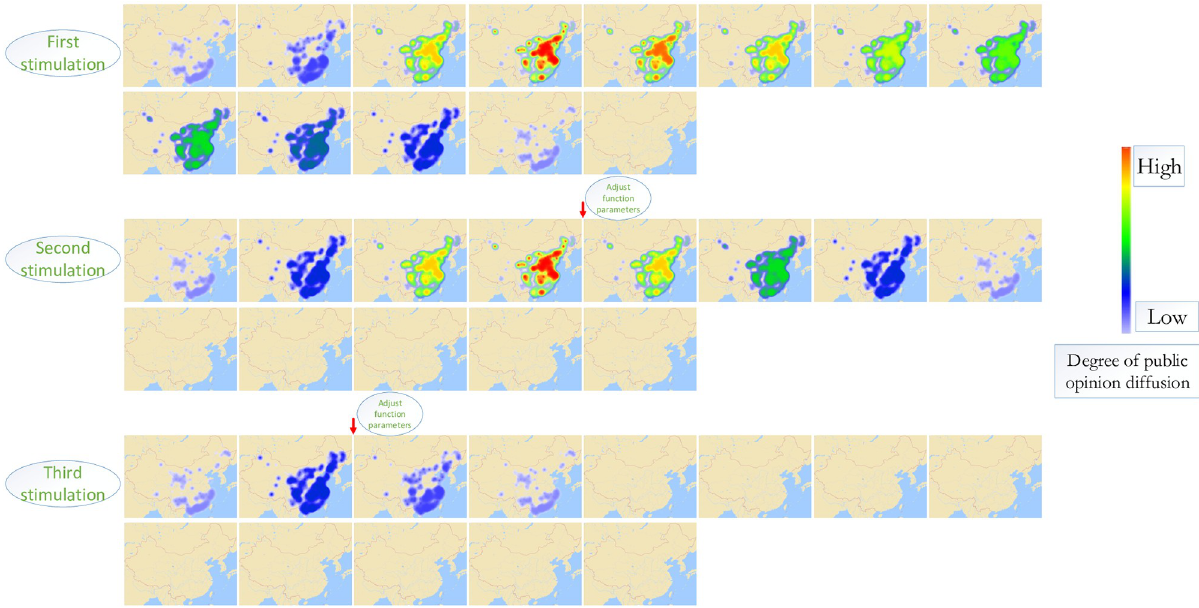
Fig 7. First simulation [25]. Republished from [https://unsplash.com/s/photos/china-map] under a CC BY license, with permission from [Unsplash], original copyright [original copyright 2020].